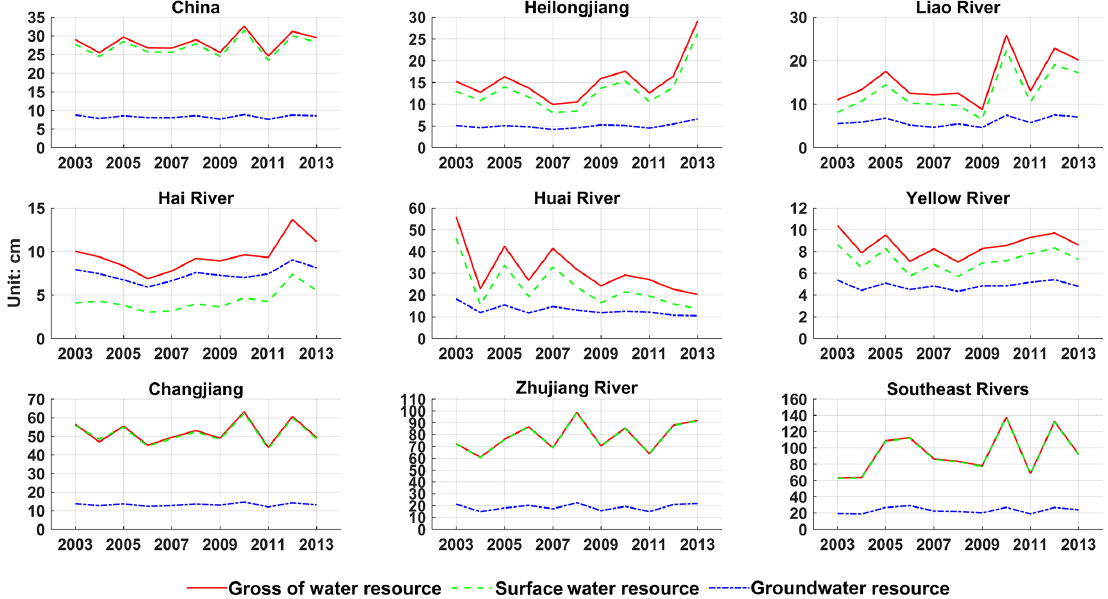
Figure 5. Annual variations of water resources in China as a whole and eight of its basins from 2003 to 2013 (unit: